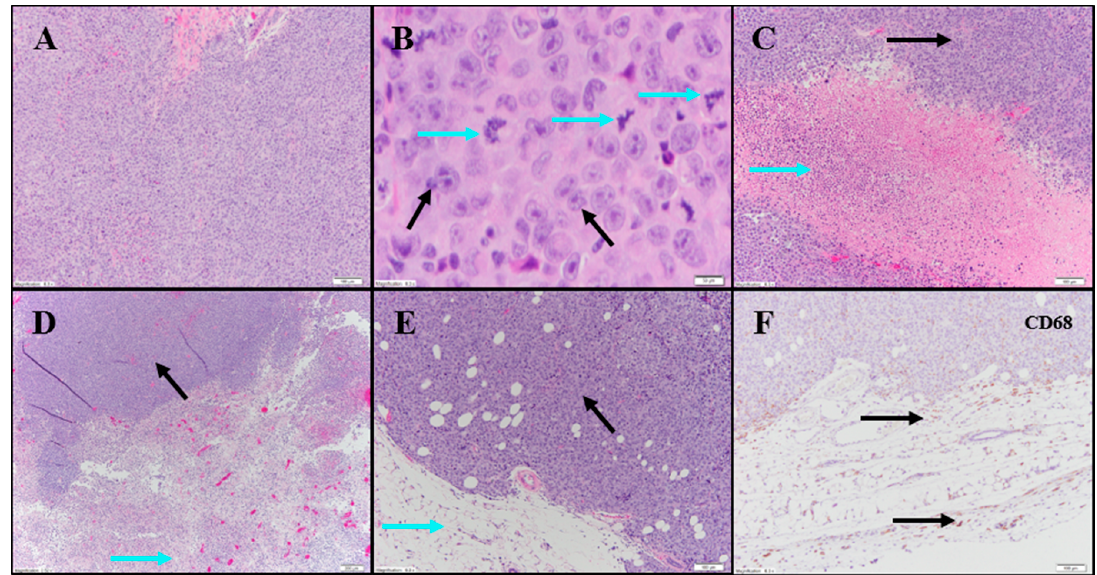
Figure 7. Representative photomicrographs of bladder tumors. Row 1: Untreated carcinoma. ( A ) Sheets of TCs 10 × . ( B ) Same animal as in ( A ): Large TCs with prominent nucleoli (black arrows) and a marked increase in mitotic figures (blue arrows) 40 × . ( C ) Same animal as in ( A ): Area of TCN (blue arrow) flanked by viable carcinoma (black arrow) 10 × . Row 2: ( D ) IT vehicle: extensive necrosis in bottom half of image (blue arrow) and viable carcinoma in top left (black arrow) 4 × . ( E ) IV Docetaxel: Viable carcinoma (black arrow). Surrounding fatty tissue with a sparse immune cell infiltrate (blue arrow) 10 × . ( F ) Anti-CD68 shows mild macrophage infiltrate in surrounding stroma (black arrows) 10 × .